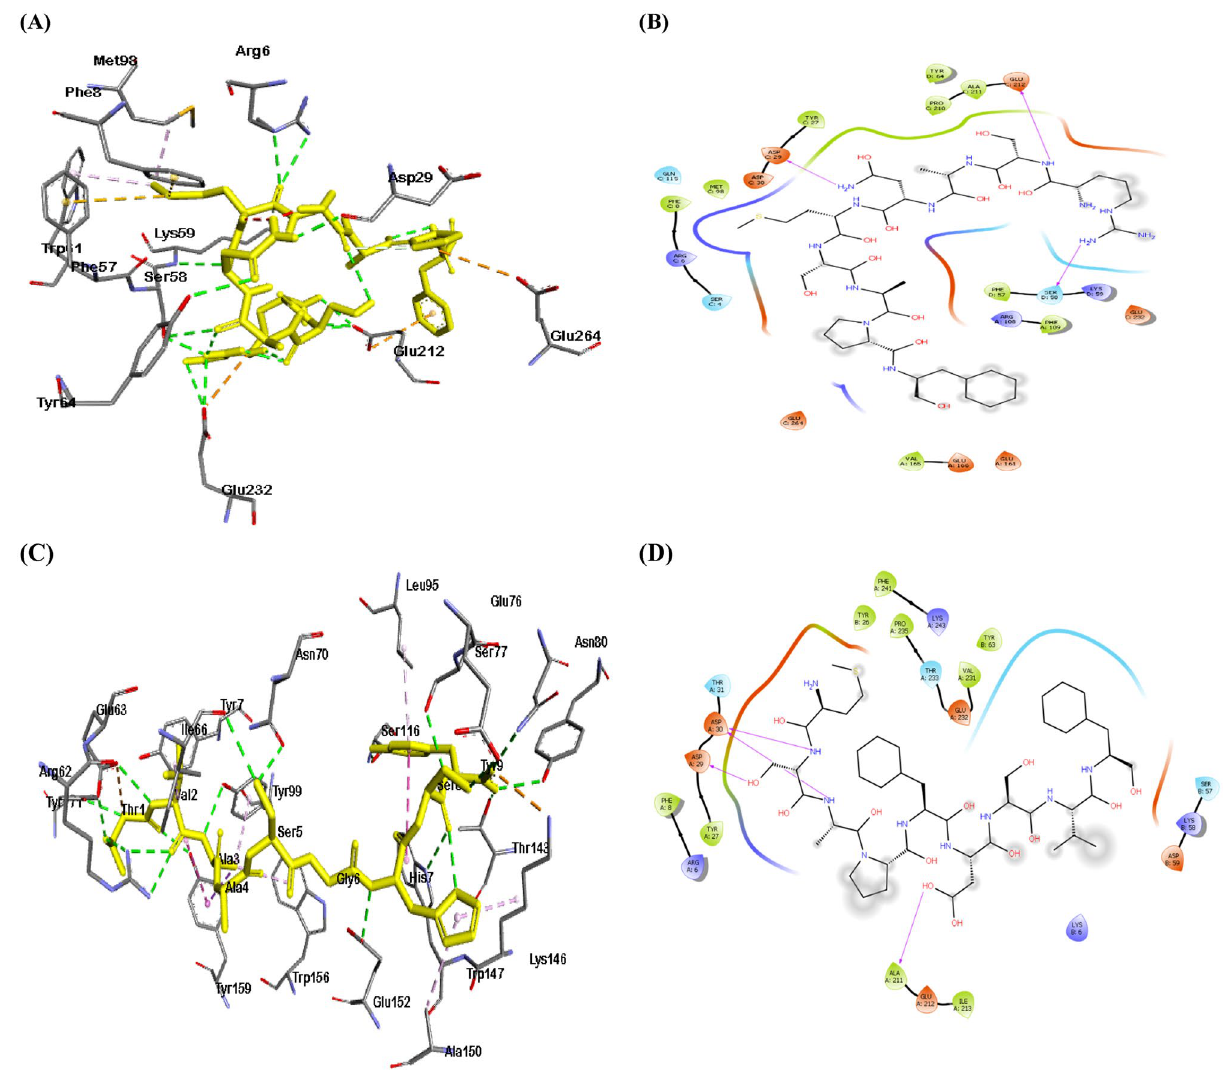
B*15:01, ( D ) 2D view for MSAPFDSVF with